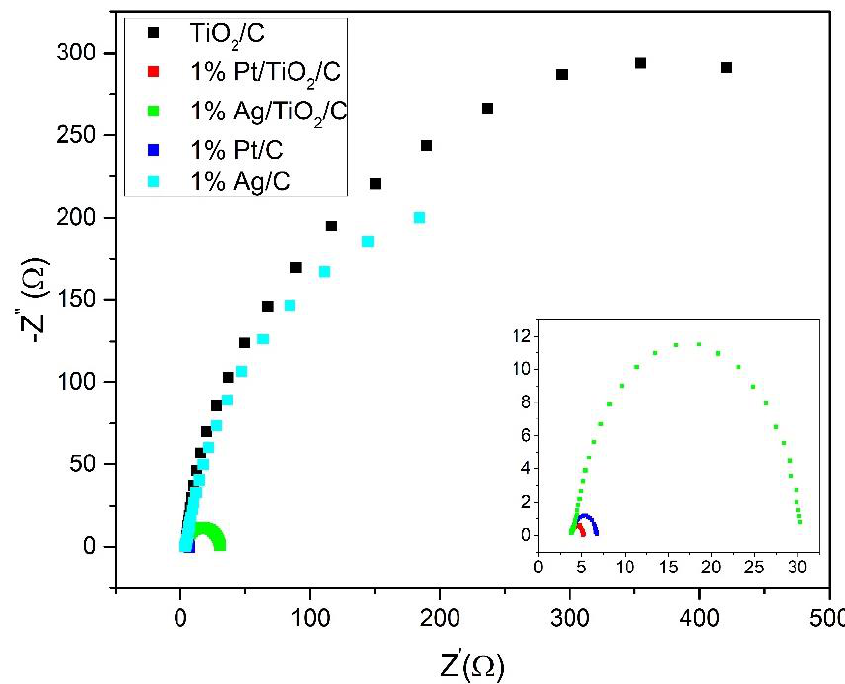
Figure 7. Electrochemical impedance measured in Ar-saturated 0.5 M H 2 SO 4 solution for M/TiO 2 /C and M/C catalysts. E = − 0.2 V vs. RHE, rotation rate: 3600 rpm.